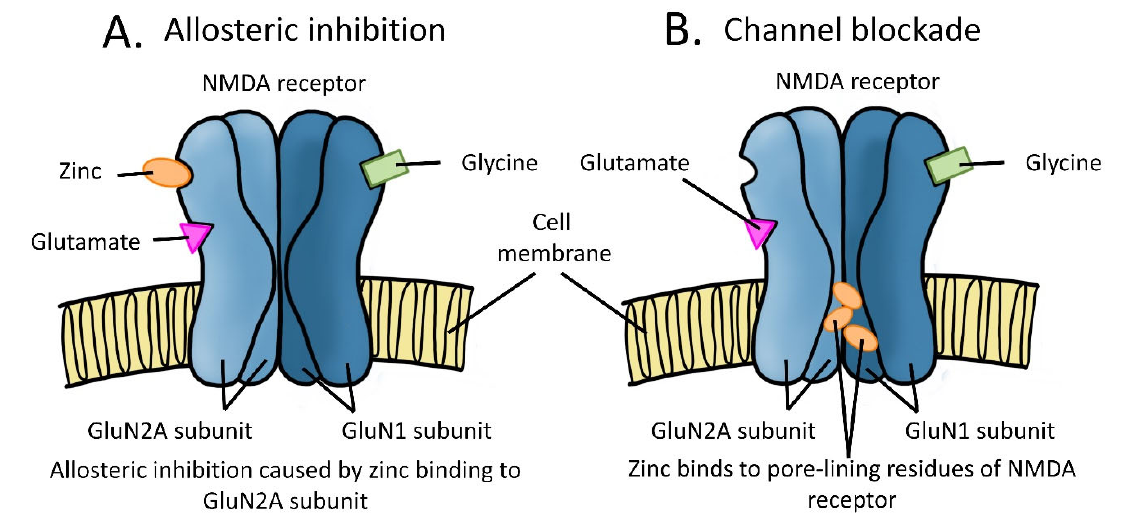
Figure 1. Schematic diagram summarising the inhibitory effects of zinc on NMDARs. ( A ) High-affinity binding of zinc to the GluN2A subunit causes allosteric inhibition by reducing the probability of the channel to open. ( B ) Low-affinity binding of zinc to the residues that line the pore of the NMDAR blocks the channel.